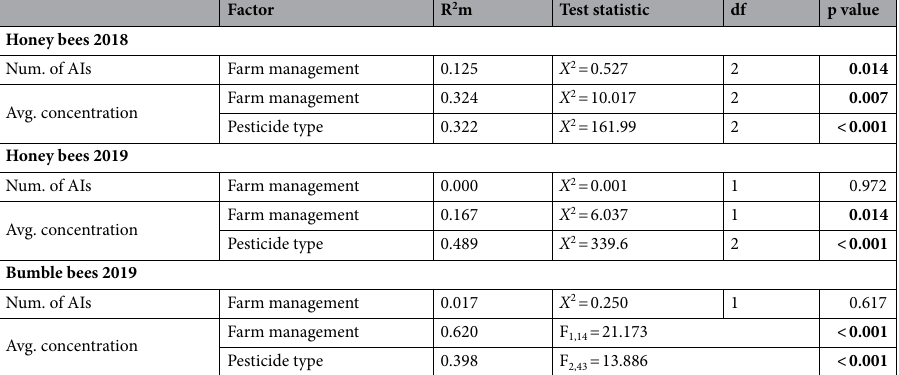
Factor R 2 m Test statistic